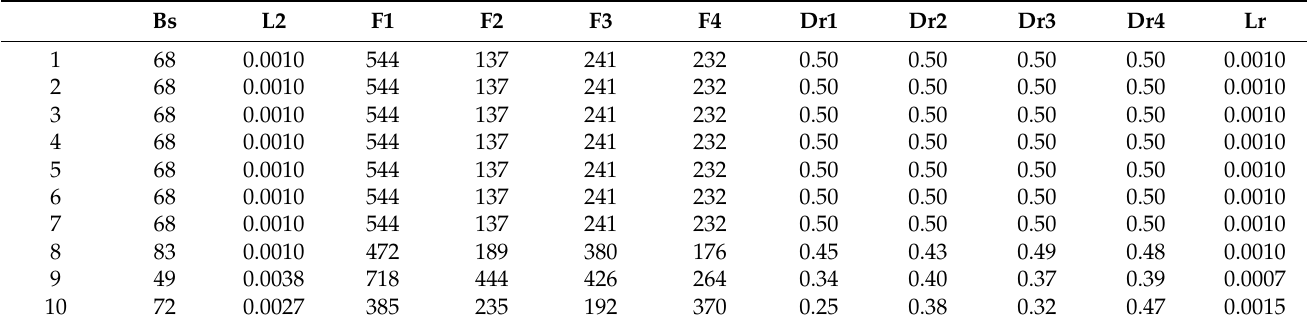
Table 14. Positions of individuals of PSO in the experiment on Five Flowers.